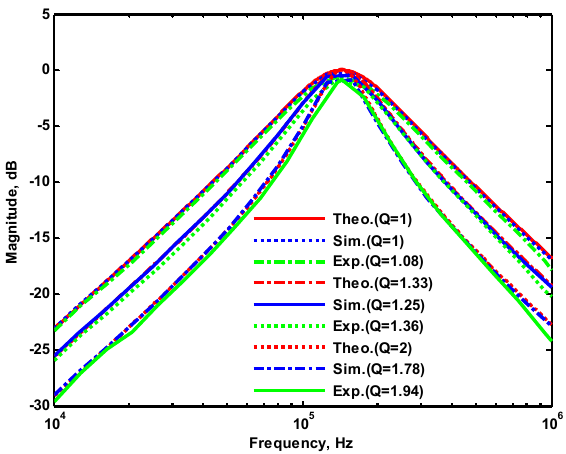
Figure 16. Theoretical, simulated, and measured gain responses of BP filters realized by varying Q while keeping f o .